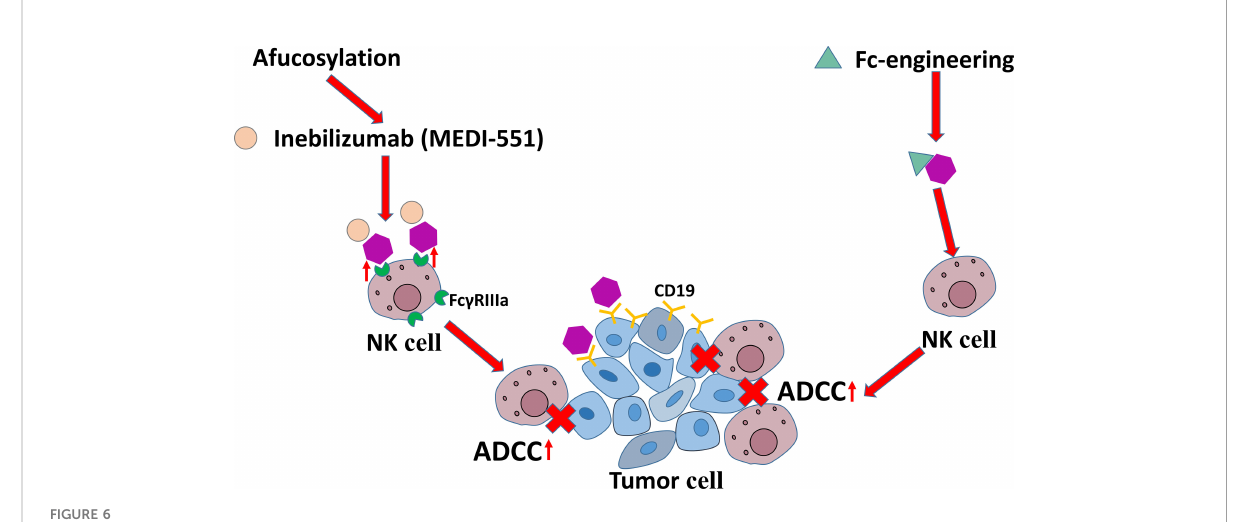
FIGURE 6 The antitumor mechanisms of anti-CD19